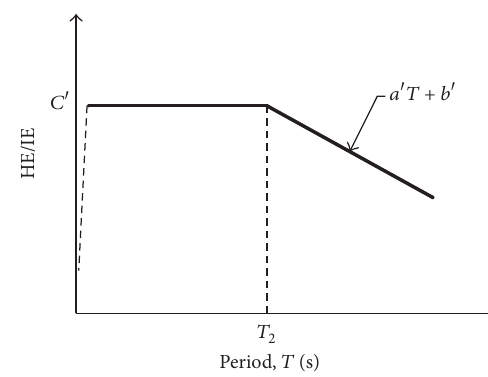
Figure 11: Proposed HE/IE spectra for hysteresis models BP, SD, and